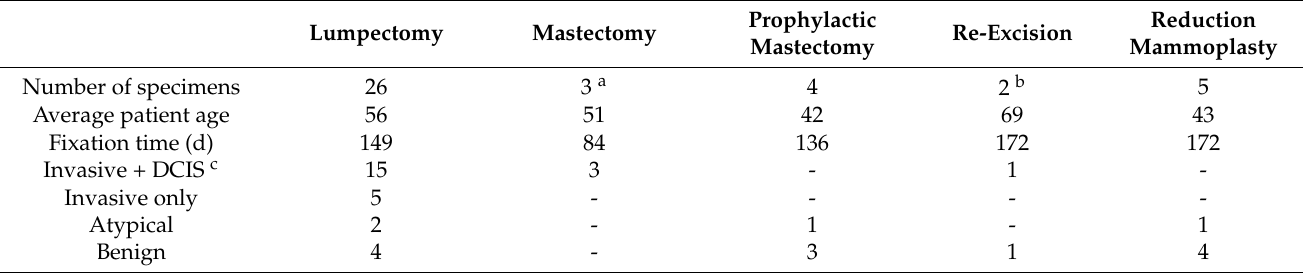
Table 1. Surgical Case Source Material for